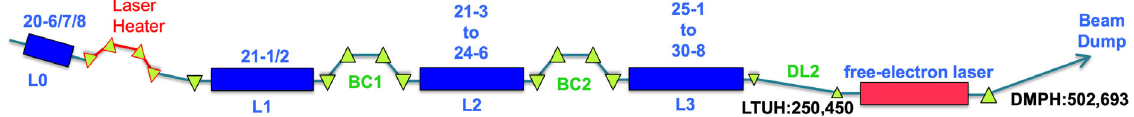
FIG. 1. Layout of the LCLS showing the location of the klystrons included in this work above the accelerating sections (blue rectangles: L0, L1, L2, and L3) and the names of the BPMs used to detect changes in beam energy: LTUH:250, LTUH:450, DMPH:502, and DMPH:693. The green triangles show dipoles and the red rectangles represent the free-electron laser undulators.